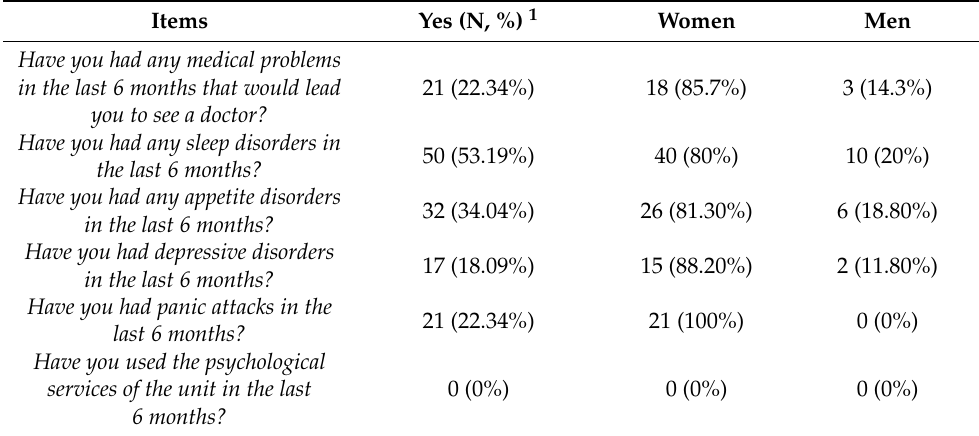
Table 2. The frequency of answers considering the psychosomatic symptoms in the last 6 months. Items